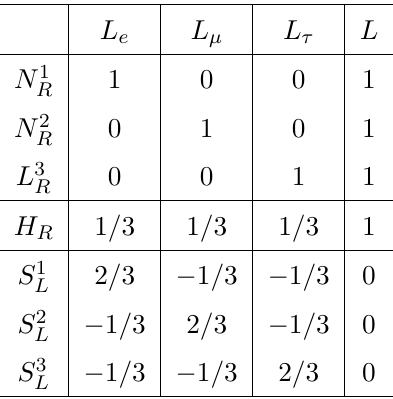
Table 1 . Leptonic quantum numbers of (cid:12)elds involved in neutrino masses. The quantum numbers in table 1 lead to the o(cid:11)-diagonal entries in eq. (2.34). In particular ( m 0 ) , de(cid:12)ned ij D